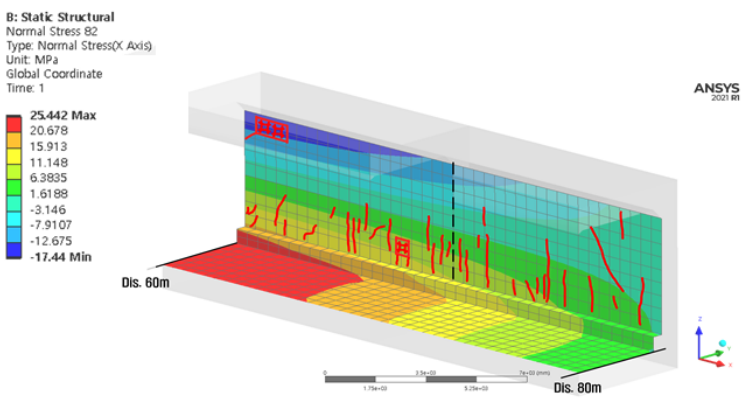
Figure 11. Comparison between the visual inspection mesh diagram and analysis results (Cell 1 wall for the settlement section.